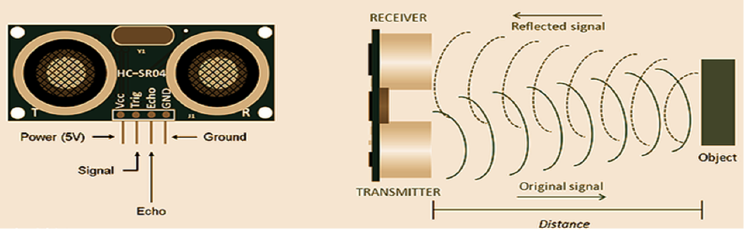
Fig. 1 Outfit ultrasonic RADAR and how it